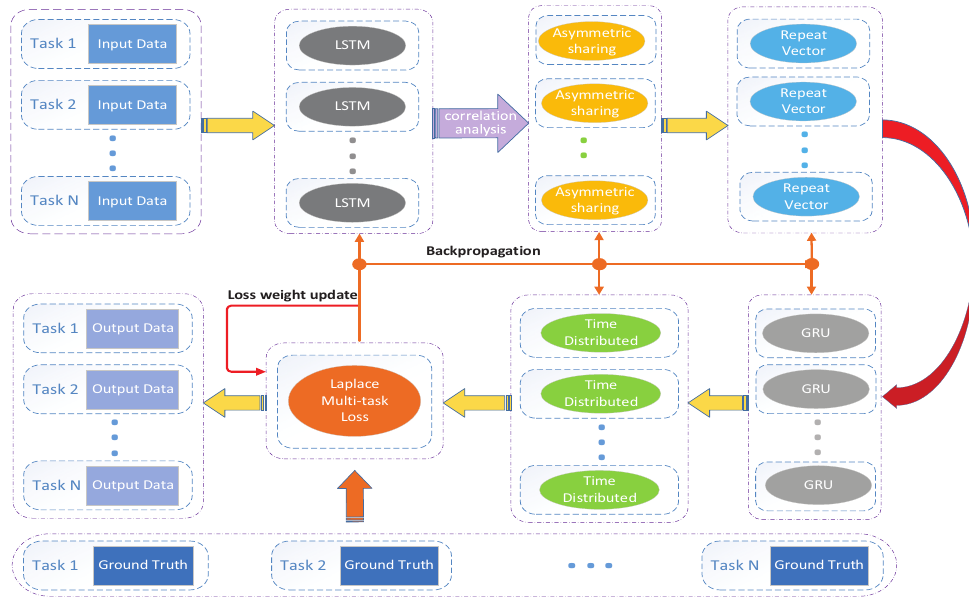
Figure 3. Architecture of simultaneous multi-parameter meteorological data prediction. The total loss of the network is generated by the backbone layer, weighted by the Laplace multitask loss layer, and the gradient updates the parameters of the Laplace multitask loss layer while back